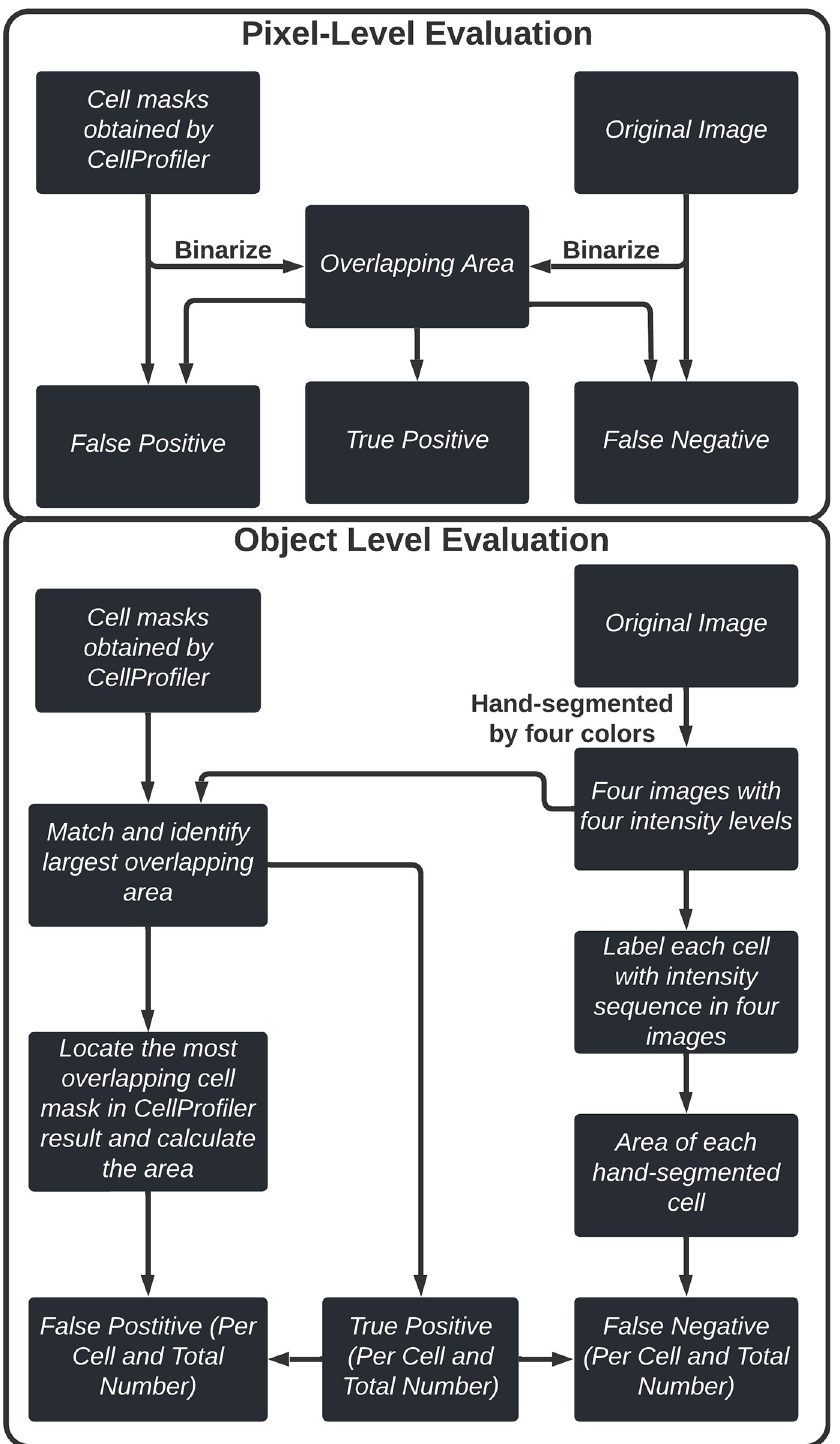
Fig 1. Flow chart of the steps in POSEA to assign pixels as TP, FP, or FN.